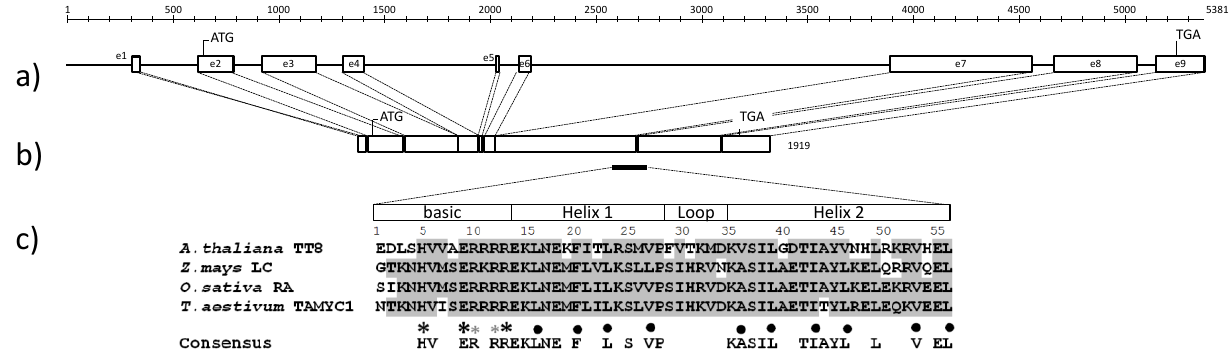
“i:S29 Pp-A1Pp-D1Pp3 P ”; ( c ) The conserved bHLH domain. The translation start site (ATG) and stop codon (TGA). Black asterisks: amino acid contacts with nucleotide bases, small gray asterisks: amino acid contacts with DNA backbone, dots: non-polar residues important for protein–protein